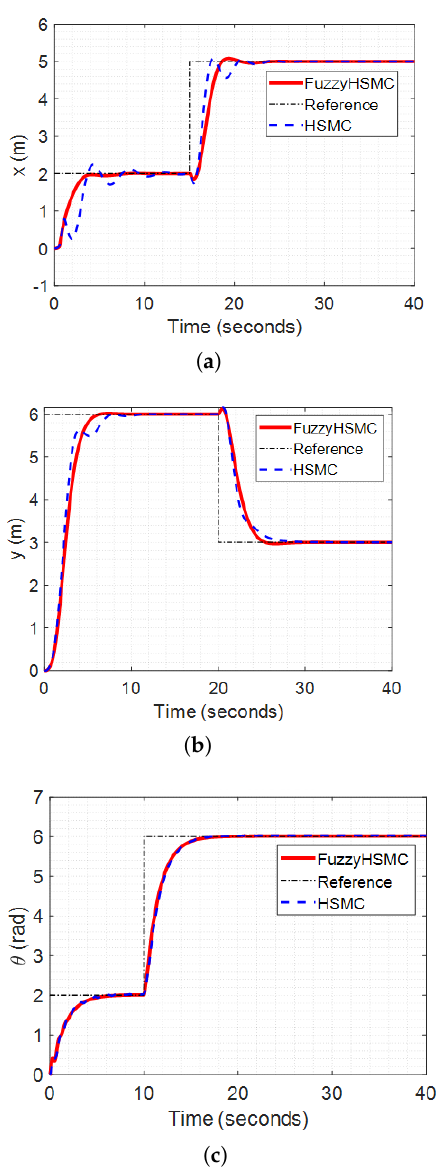
Figure 6. The actuated states given the step input. ( a ) The trolley position x ( t ) . ( b ) The bridge position y ( t ) . ( c ) The pulley angle θ ( t ) .